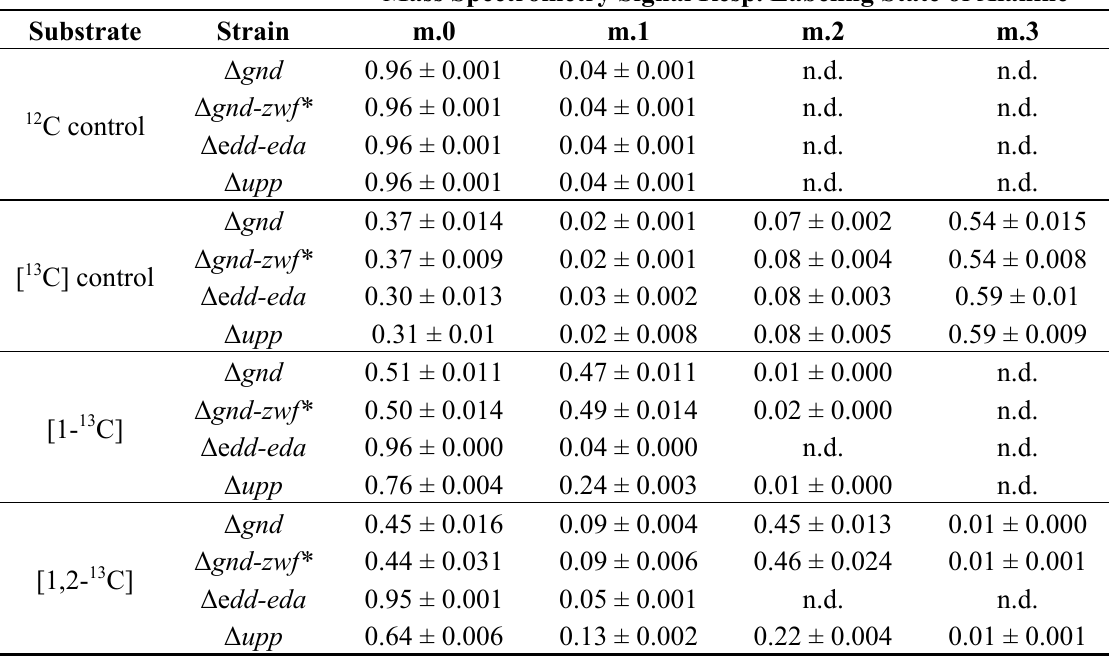
Table 1. Mass isotopomer fractions in alanine of the four strains Δ gnd , Δ gnd zwf *, Δ edd - eda , and Δ upp cultivated with differently 13 C labeled substrates. The isotopic state of alanine can be unlabeled (m.0), single (m.1), double (m.2), or triple (m.3) 13 C labeled. All values were generated from at least two biological replicates with two technical replicates each. The values for ( 13 C) samples represent six biological replicates each. All values are corrected for their inoculation labeling pattern. The nomenclature of the 13 C labeling states of the metabolites is presented in Section